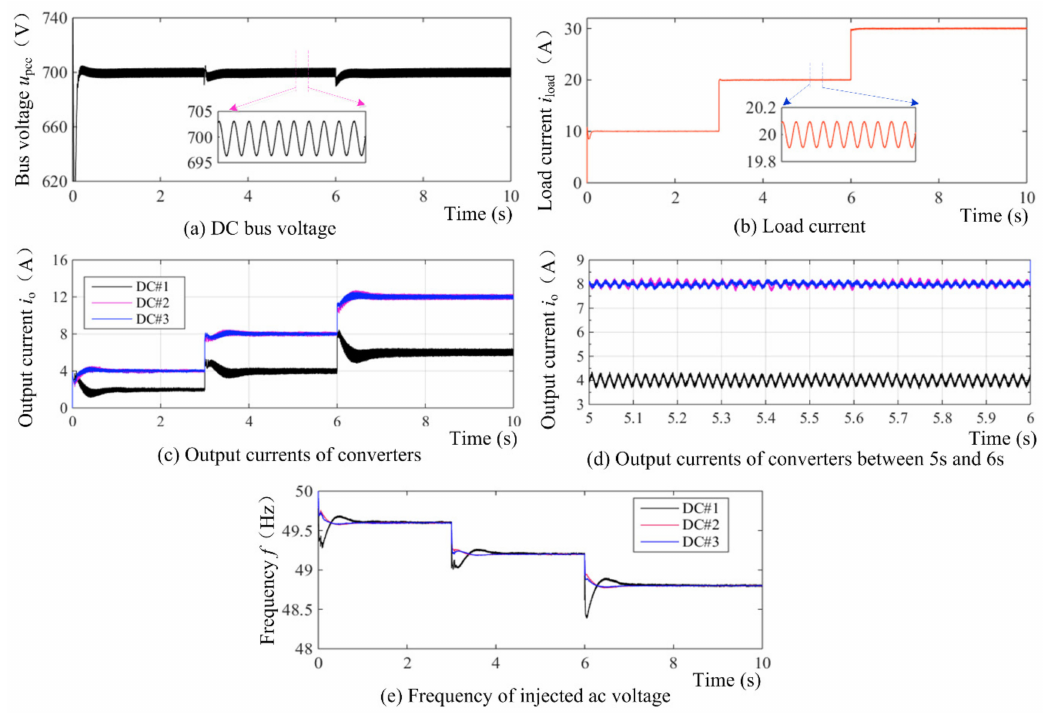
Figure 8. Simulation results of three paralleled converters with unequal power